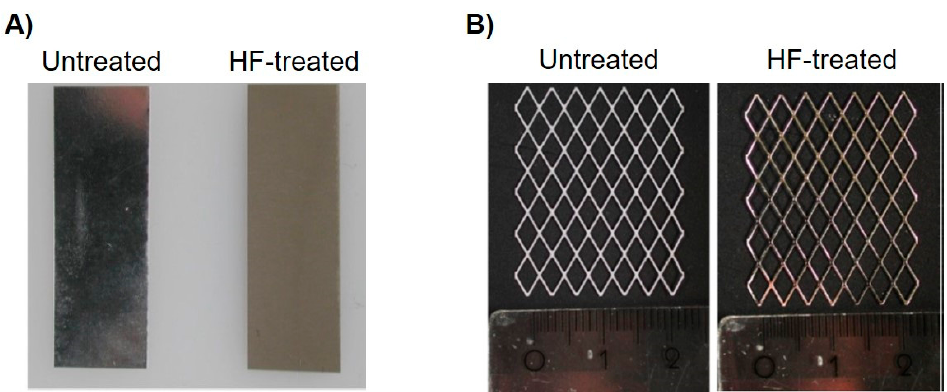
Figure 2. Comparison of untreated and processed samples. ( A ) Pictures of both an untreated and HF-treated magnesium sheet for the in vitro experiments. ( B ) Processed magnesium meshes before embedded into a collagen membrane.